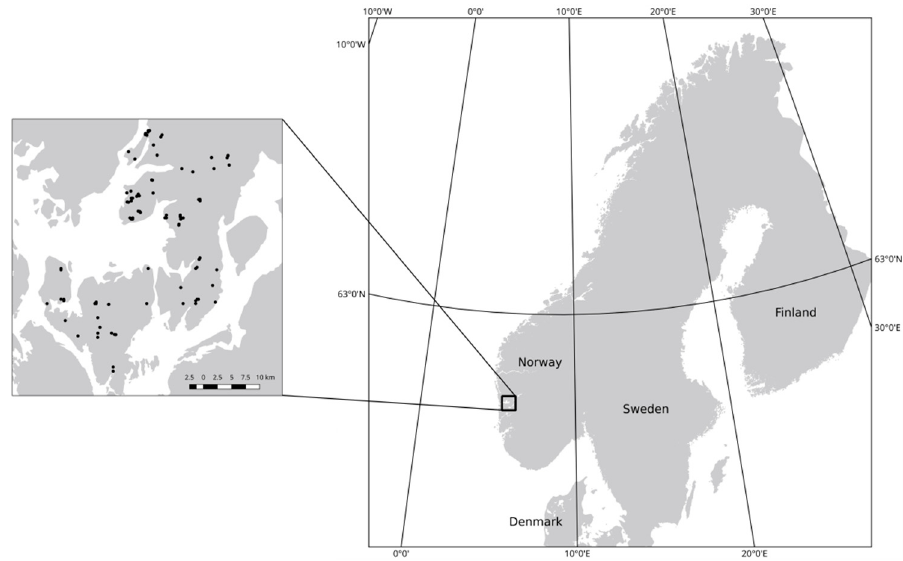
Figure 1. Map of the study area. Field reference locations are represented by black dots.